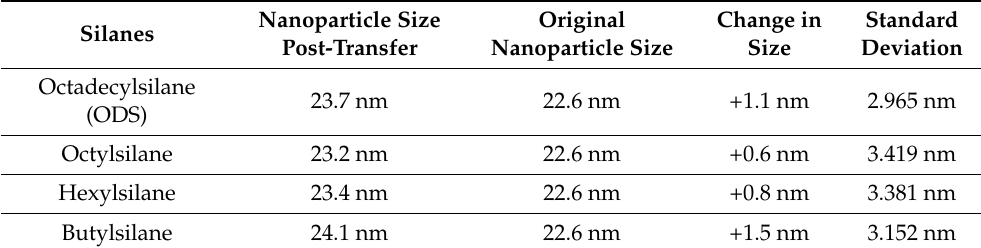
Original Nanoparticle Size